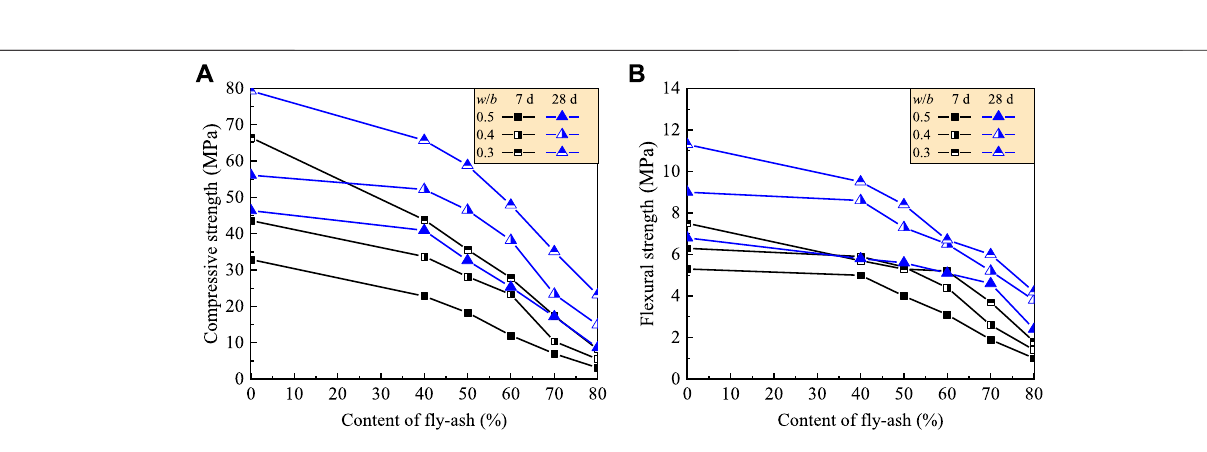
Frontiers in Materials |